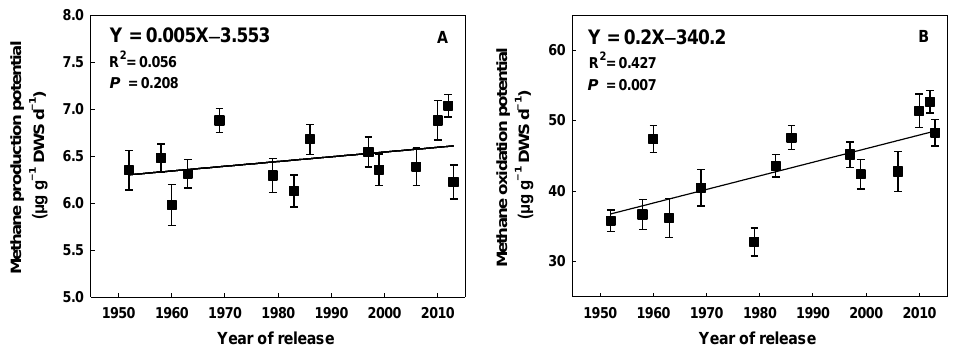
Figure 4. Changes in methane production potential ( A ) and methane oxidation potential ( B ) in rhi- zosphere soil during japonica rice cultivar renewal. Solid squares indicate the mean value of two experimental years for each cultivar, and error bars indicate the standard errors of the mean. Solid lines indicate linear regression lines.